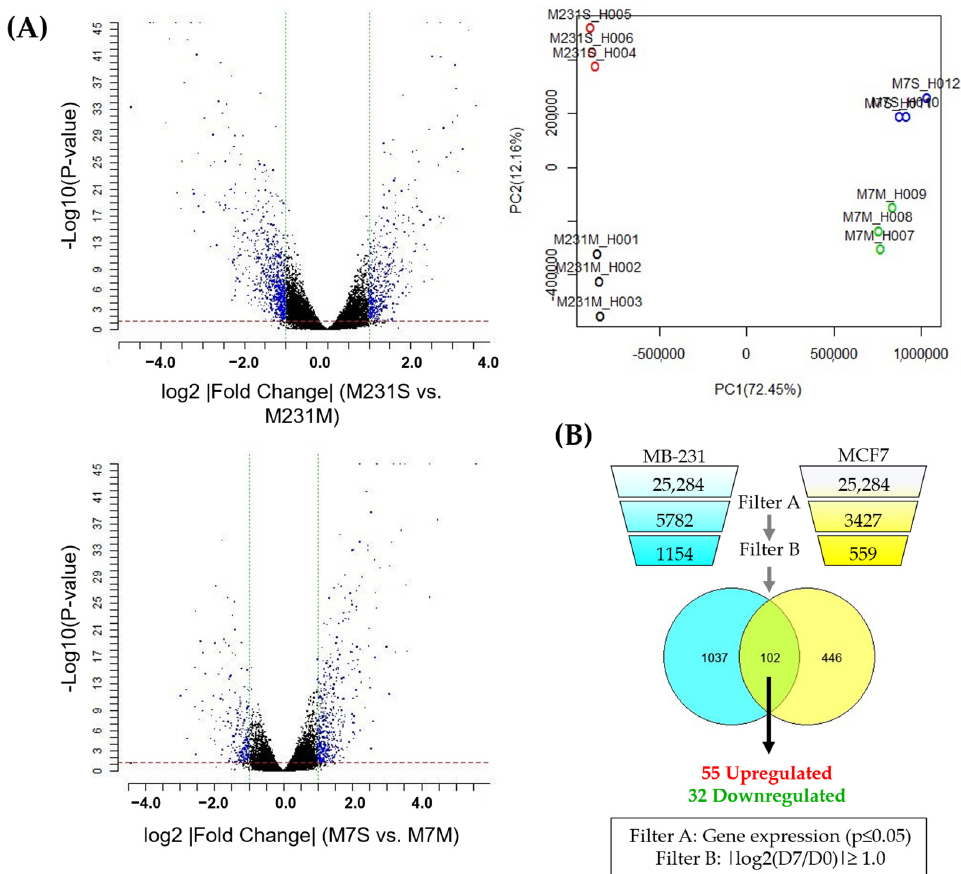
Figure 2. Molecular signature of suspension-cultured breast cancer cell lines using Gene